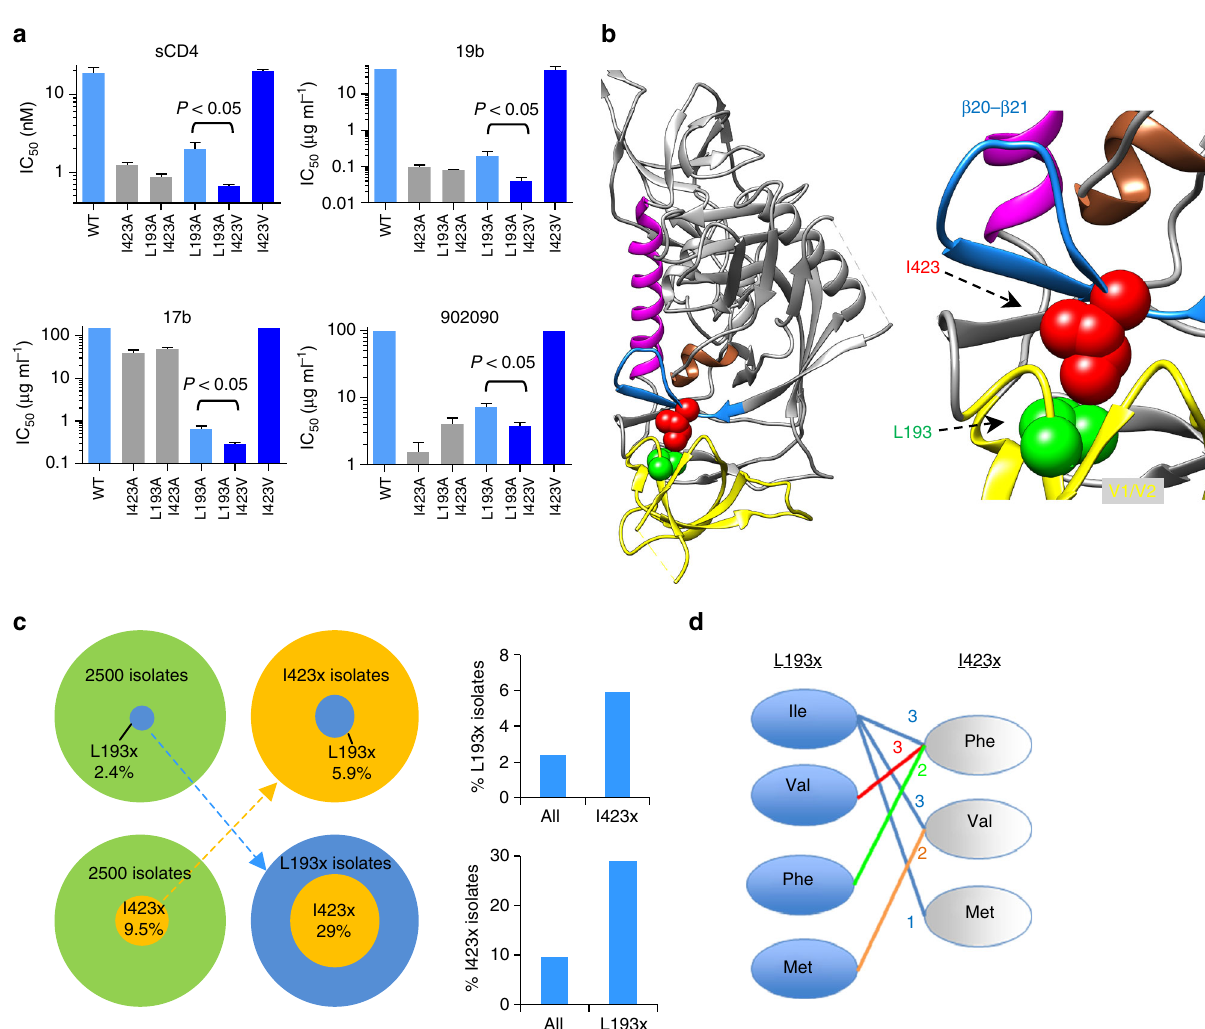
Fig. 6 Interaction between residues in the gp120 β 20 – β 21 element and the V1/V2 region. a The individual and combined effect of changes in Ile 423 and Leu 193 on the sensitivity of HIV-1 to ligands recognizing downstream conformations. Results shown are averages of those obtained in two or three independent experiments and error bars represent s.e.m. Indicated P values were calculated using a two-sample t test. b Leu 193 and Ile 423 were mapped on a structure of HIV-1 Env bound to the PGT151 antibody (PDB ID 5FUU) 36 . c Analysis of the prevalence of amino acids other than isoleucine at position 423 or leucine at position 193 among 2500 primary HIV-1 strains. Green pie plots show the prevalence in all HIV-1 strains and residue-speci fi c pie plots (set to the same size as the green plots) show the prevalence of speci fi c amino acids within the HIV-1 subpopulation that carries amino acids other than isoleucine at position 423 or leucine at position 193. d Possible combinations of different amino acids at Env residues 193 and 423 in primary HIV-1 strains. The number of isolates with the speci fi ed pairing is